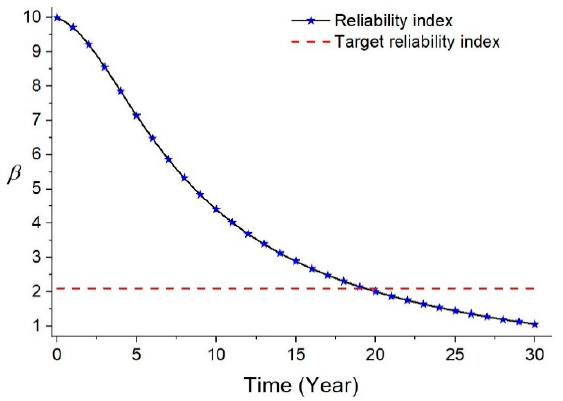
Figure 13. Cumulative reliability index trend.